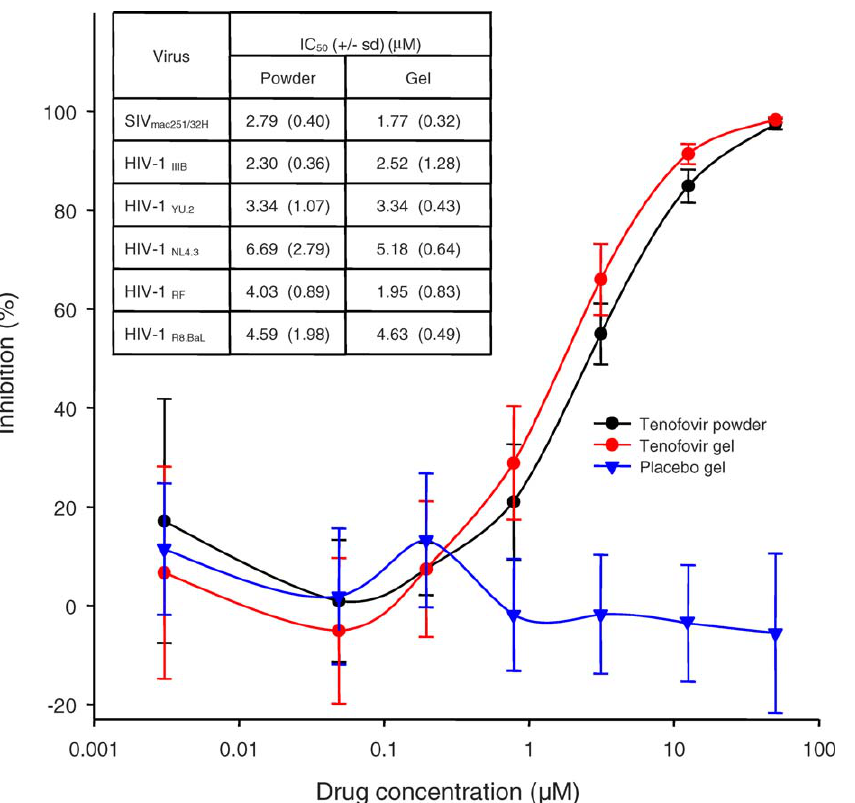
Figure 1. Solution and Gel Formulated Tenofovir Inhibited SIV mac251/32H Infectivity In Vitro at Similar Doses and in the Same Range as for Representative HIV-1 Isolates Infection of TZM-bl indicator cells in the presence and absence of tenofovir was compared by luminescence analysis of cell lysates and the results expressed as percent inhibition. The graph shows the full titration of drug formulations on infection with SIV mac251/32H ; the virus stock used in subsequent challenge experiments in vivo. Each point represents the mean of three independent experiments performed in triplicate þ / (cid:2) standard deviation. The results for a panel of HIV-1 strains in comparison to SIV mac251/32H are shown as IC 50 values in the inset.